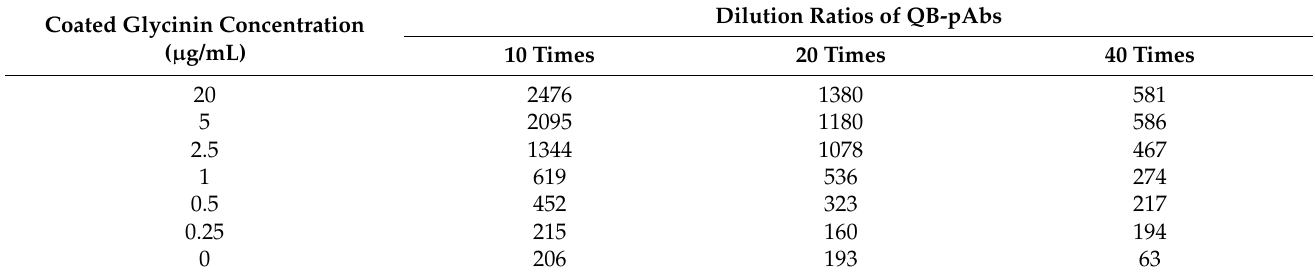
Table 1. The optimization of coated glycinin concentrations and QB-pAbs dilution ratios using checkerboard ( n = 3).